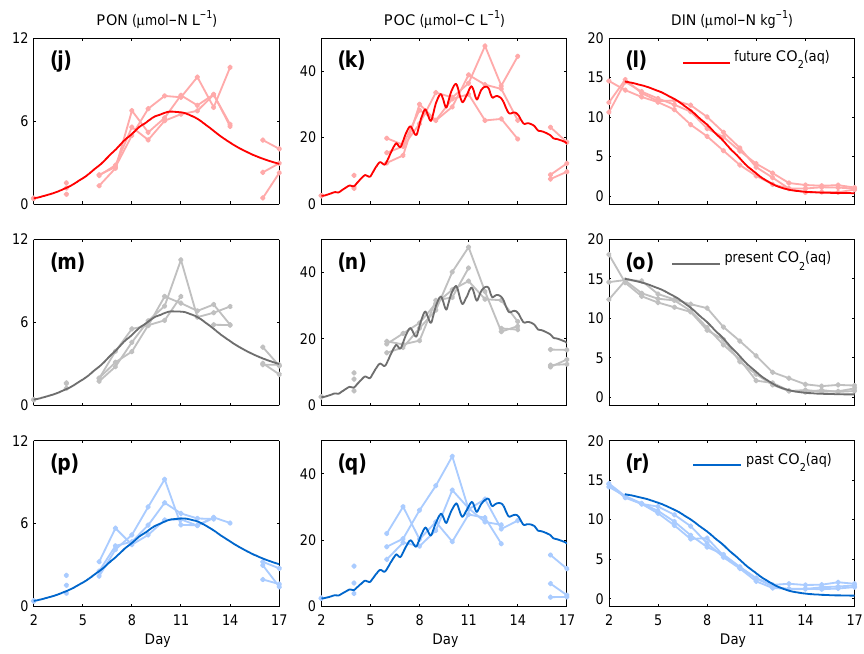
Figure 3. As in Fig. 2 for PeECE